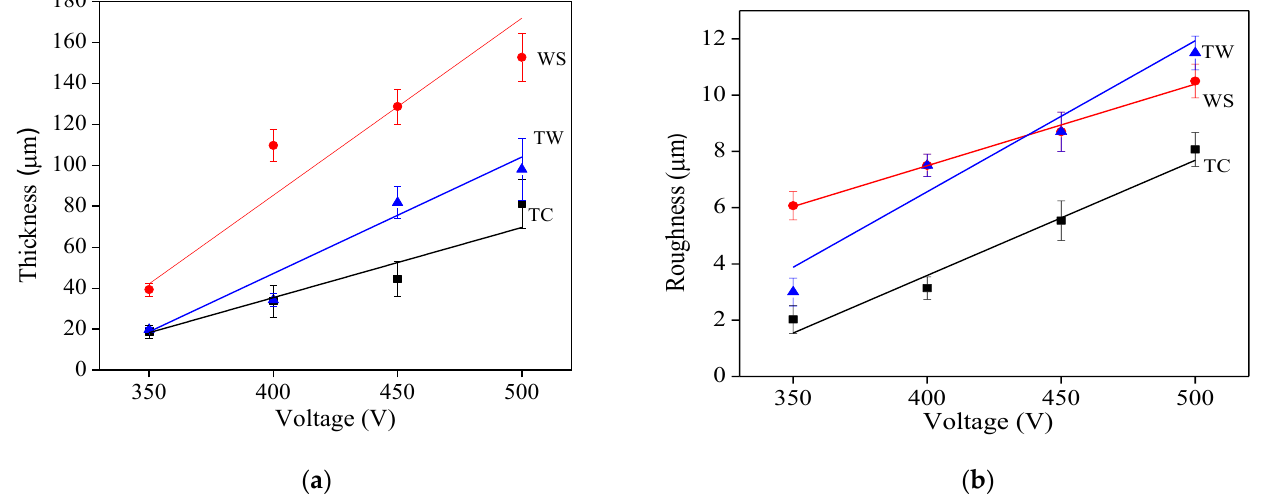
Figure 4. Graphs of the coatings thickness ( a ) and roughness ( b ) versus the voltage of the coating’s deposition.